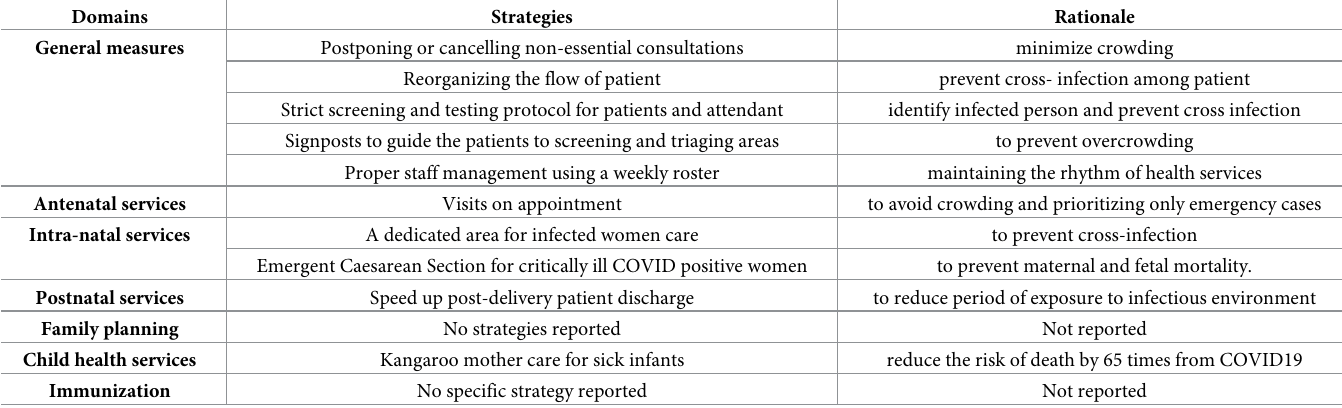
Table 3. Strategies to ensure MCH services with quality care during pandemic related health emergencies (Zika, Ebola and COVID-19).